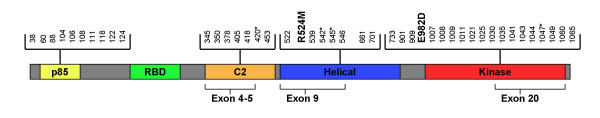
PIK3CA structure. Schematic diagram of Pik3ca protein illustrating functional domains and mutations (grouped by domain) reported to date [22, 30, 32, 33, 40, 41]. Codons with frequent missense mutations reported ('hotspots') are denoted by asterisks. Location of experimentally found mutations in this study are denoted in boldface. p85, PI3K p85 regulatory subunit binding domain; RBD, Ras binding domain; C2, calcium-dependent phospholipid-binding domain; Helical, PI3K helical domain; Kinase, PI3/4-kinase domain.